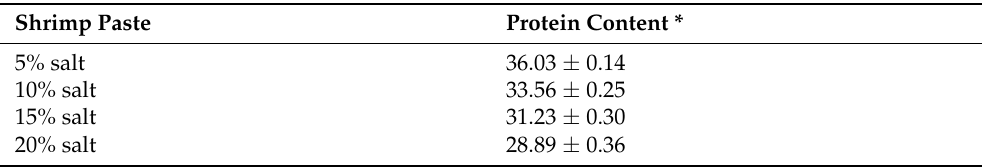
Table 1. Protein content of shrimp paste with different salt concentrations, after 48 h of fermentation. Protein content was analyzed via the Kjehdal method in three replicates.